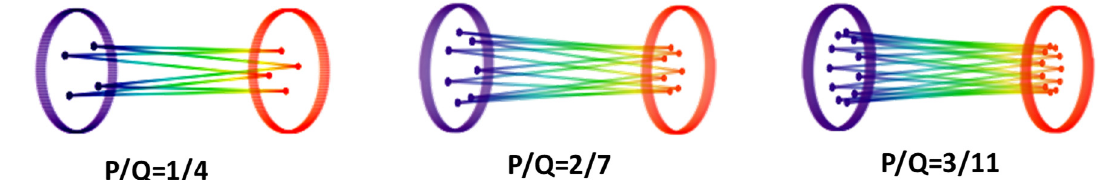
Figure 3. Nonplanar periodic orbits for P / Q = 1/4, 2/7, and 3/11 with N x = N y and φ x − φ y = π